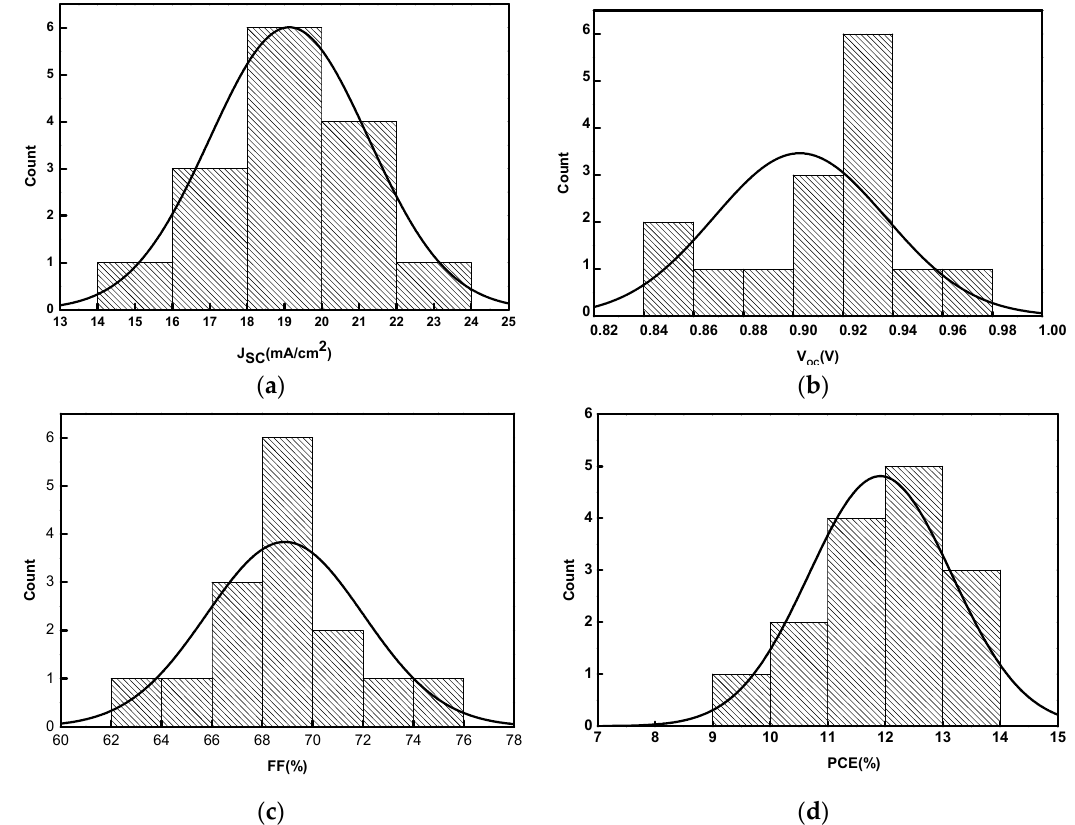
Figure 6. Histograms of photovoltaic parameters. ( a ) J SC , ( b ) V OC , ( c ) FF, and ( d ) PCE for PSC based on Ni/Au mesh electrode. The histograms shown are the photovoltaic parameters for 15 devices.